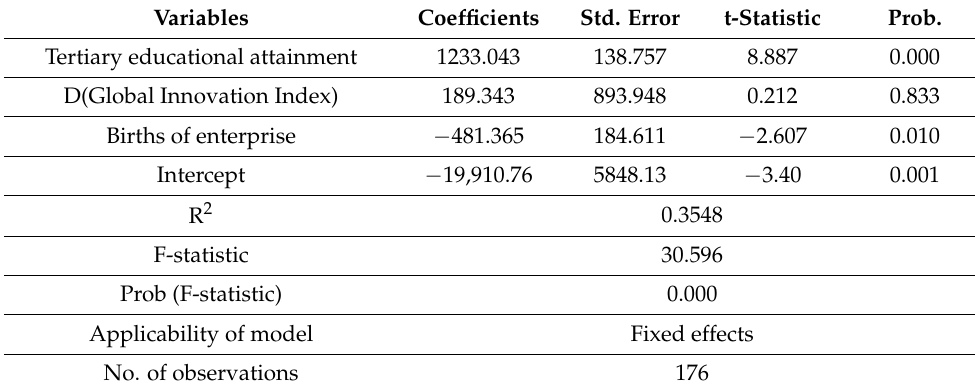
Table 7. Static panel